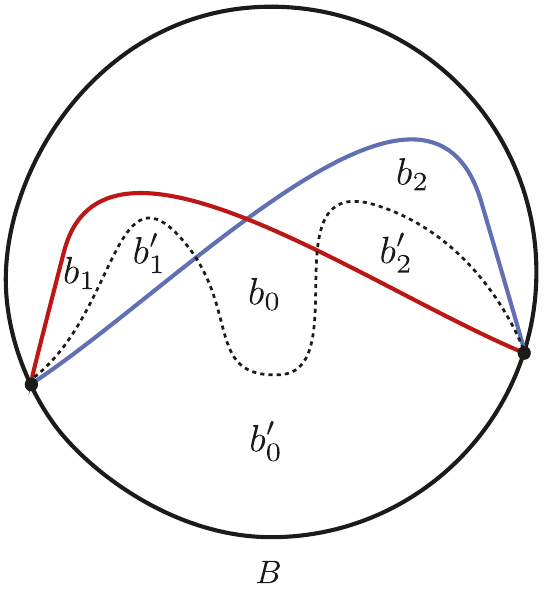
Figure 7 . Setup in the proof of Property 1. Both the region bounded by the blue surface and that bounded by the red surface are assumed to satisfy (7.1). We prove that therefore the union of those regions satisfies (7.1), by showing it to hold for an arbitrary choice b 0 = b 0 bounded by the dashed black